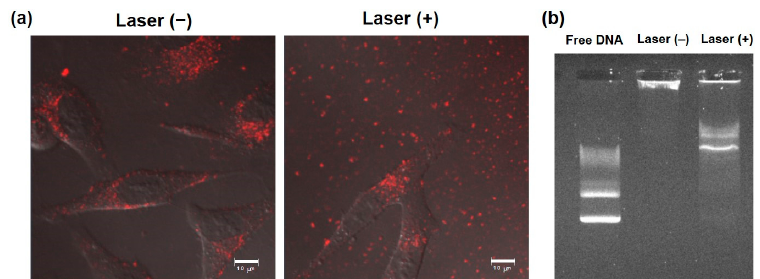
Figure 6. Effect of NIR laser irradiation on interaction with cells and DNA release from complexes. ( a ) Confocal laser scanning microscopic images of HeLa cells treated with Rh-labeled pDNA-containing complexes for 1 h and with or without subsequent 1 min-laser irradiation. Cells were observed at 30 min after laser irradiation without washing. Scale bars represent 10 µm. ( b ) DNA release under NIR laser irradiation. Complexes with or without 1 min-laser irradiation were electrophoresed and fluorescent bands derived from DNA were observed.